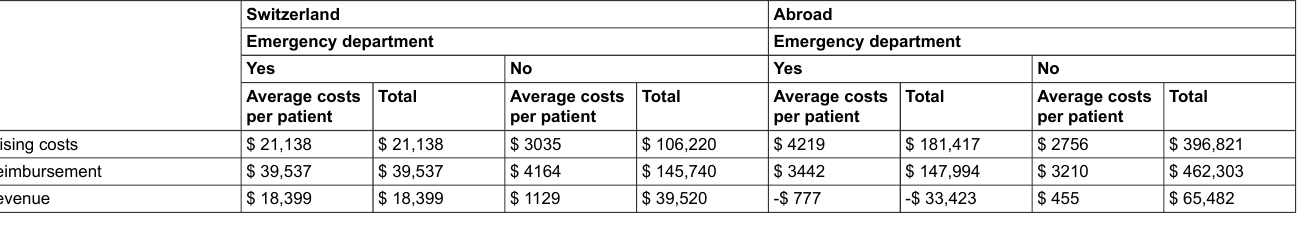
Table 3: Average costs of cases presented through emergency department and at our outpatient